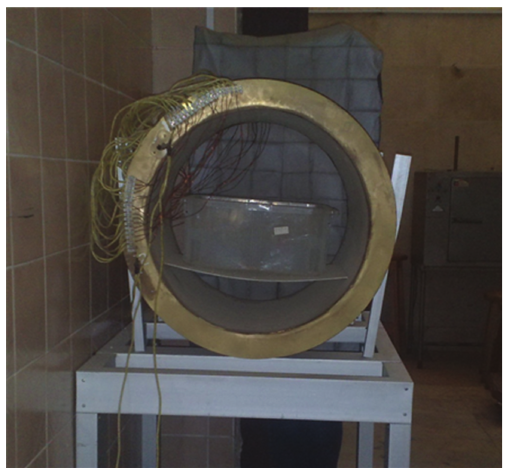
Figure 1: Experimental setup of the exposure